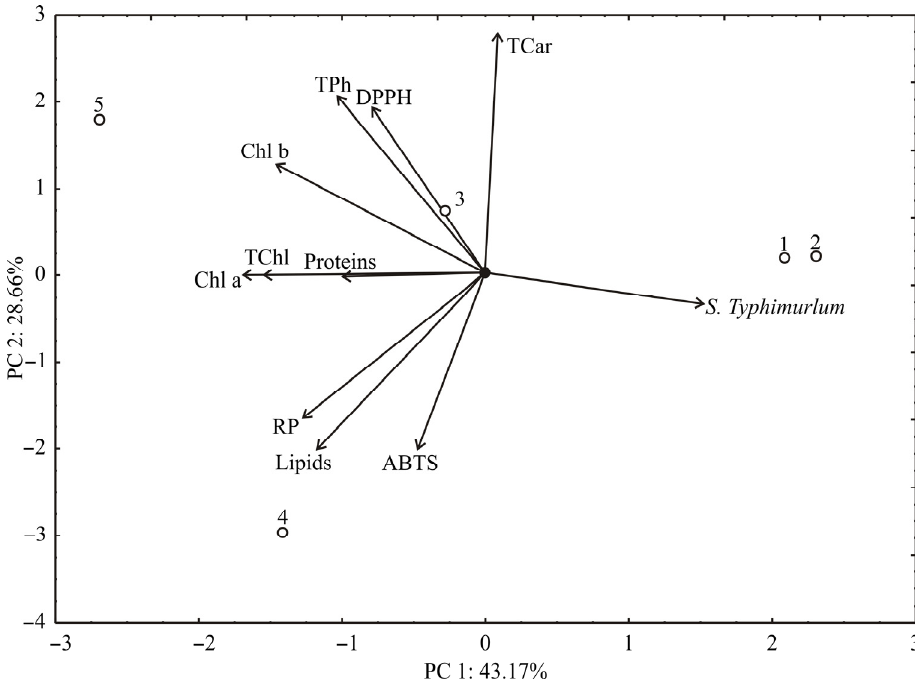
Figure 2. PCA ordination of variables based on correlations of pulp samples.